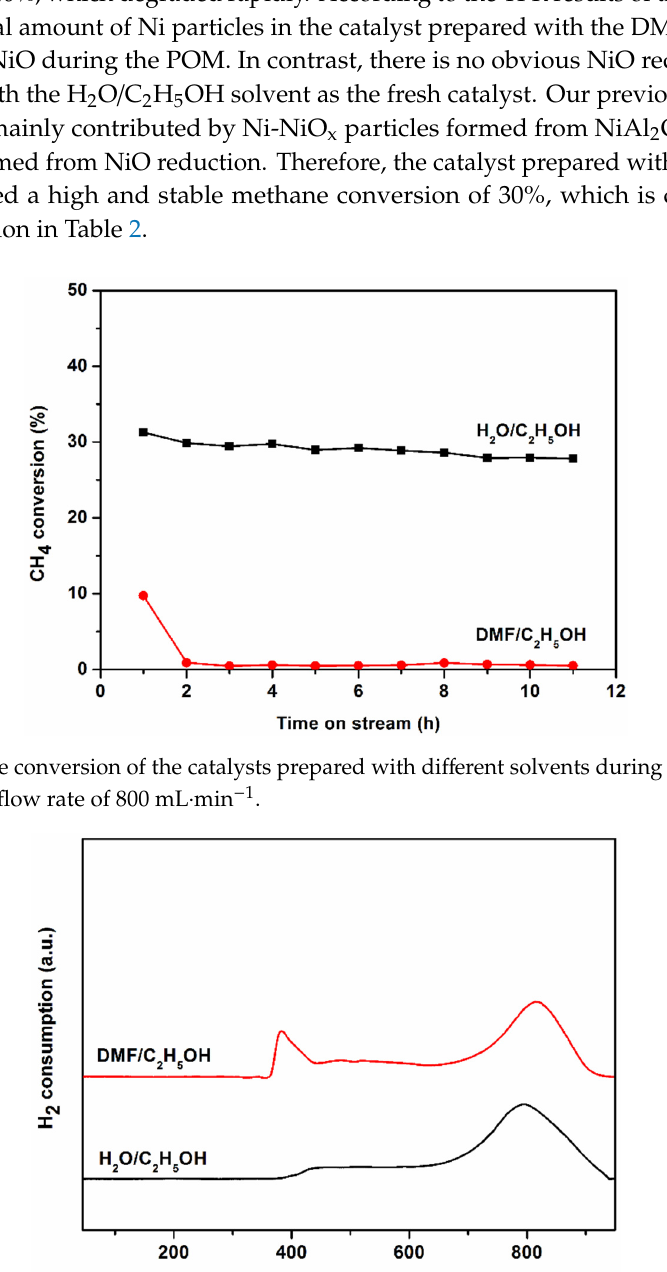
Figure 3. TPR profiles of the catalysts prepared with different solvents. Table 2. Reducibility and Ni dispersion of Ni/Al 2 O 3 catalysts.